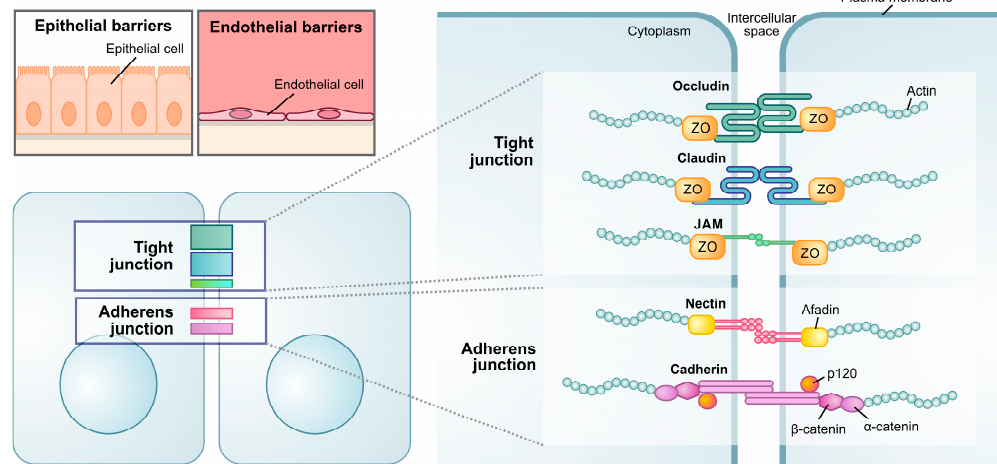
Figure 3. Structures of epithelial and endothelial barriers.